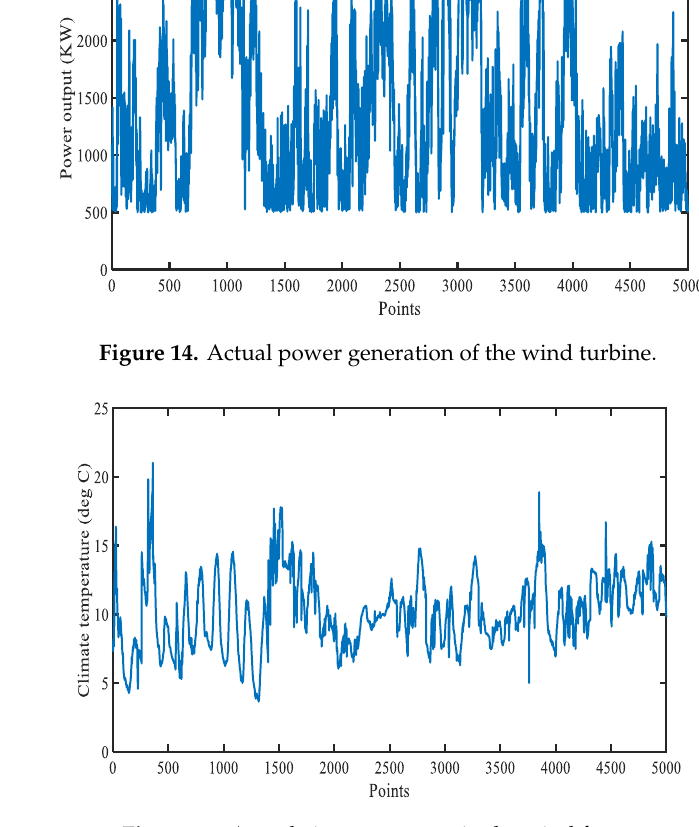
Energies 2019 , 19 , x FOR PEER REVIEW Figure 15. Actual air temperature in the wind farm. Figure 15. Actual air temperature in the wind farm. Figure 15. Actual air temperature in the wind farm.